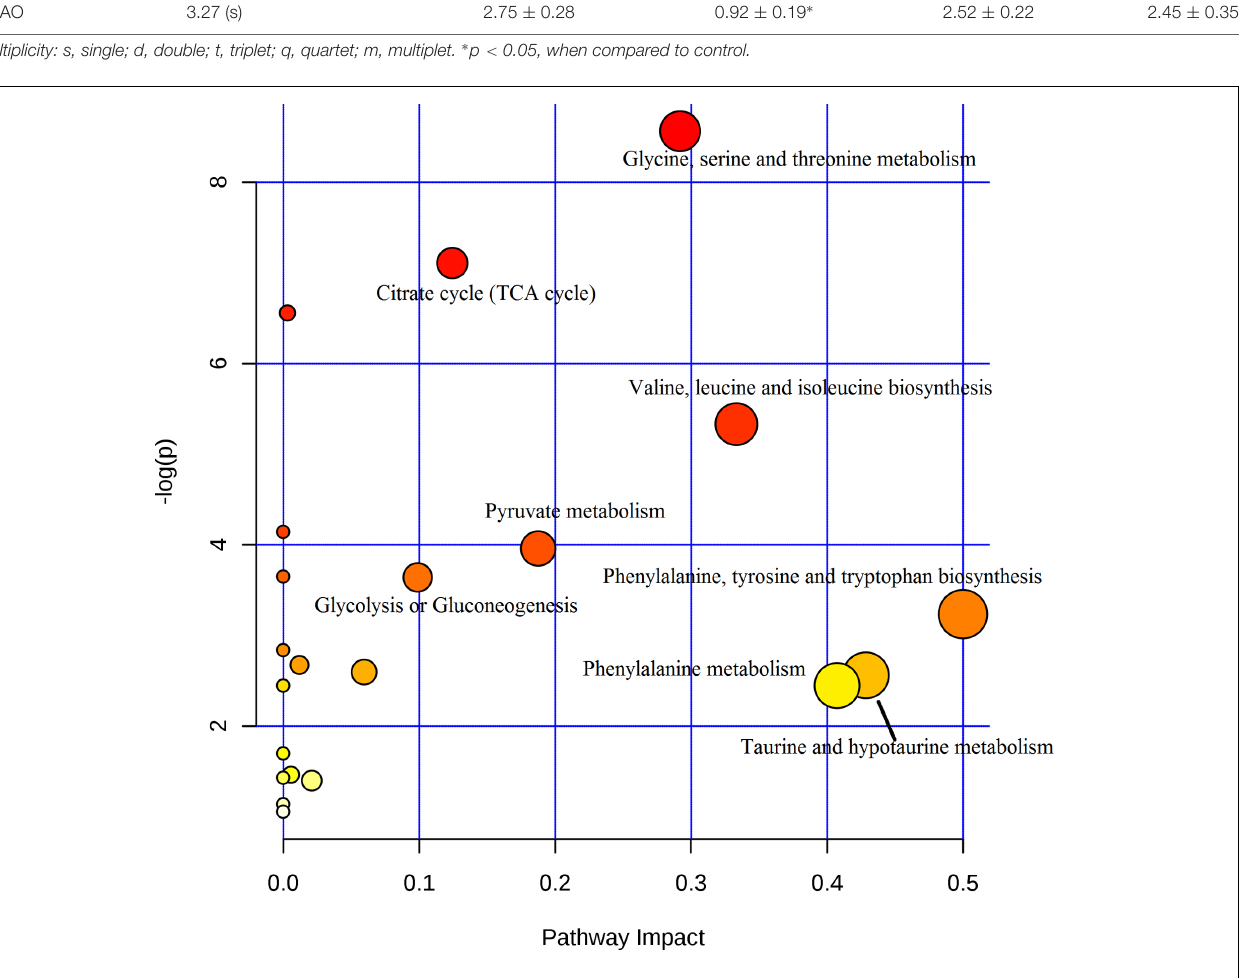
(R2X = 0.75) and 75.5% of the variation in the response Y (class; R2Y = 0.68) with a predictive ability of 60.8% (Q2Y = 0.608). The corresponding loading plot ( Figures 4H,J ) showed